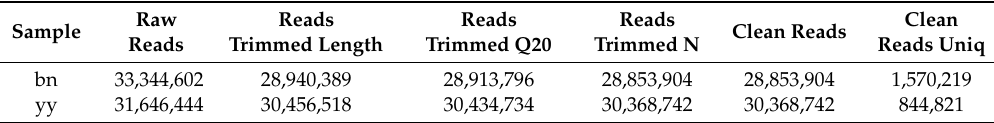
Table 1. Clean reads statistics in the libraries of vegetative cells and dormant